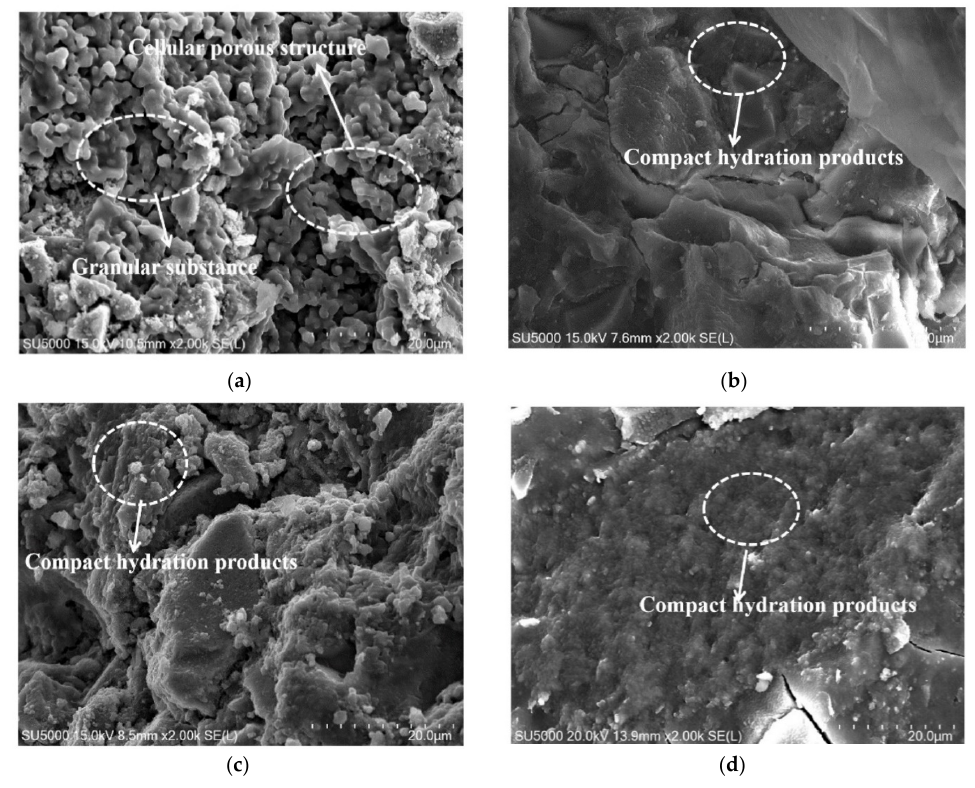
Figure 7. The SEM morphology of alkali-activated blast furnace slag powder with MgO. ( a ) With 10% MgO-3 d. ( b ) With 10% MgO-28 d. ( c ) With 30% MgO-3 d. ( d ) With 30% MgO-28 d.